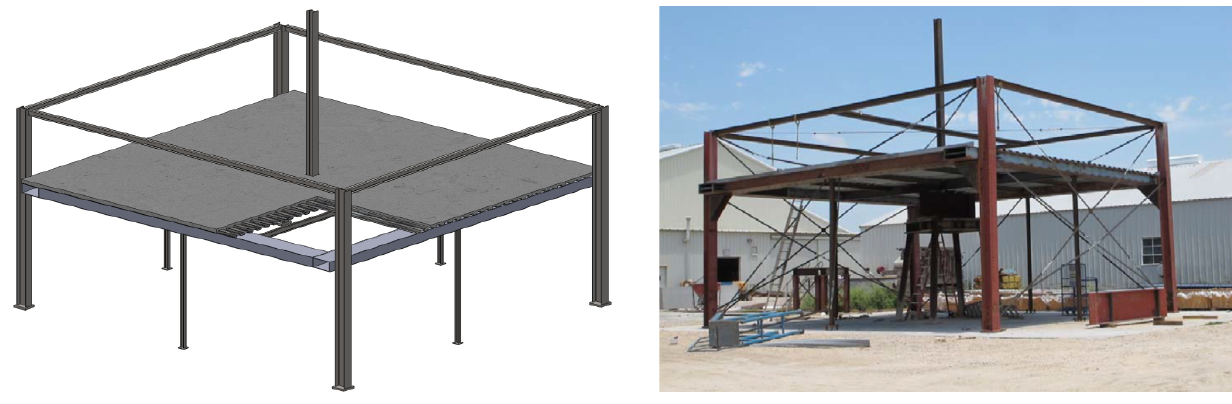
Figure 8. Test specimen